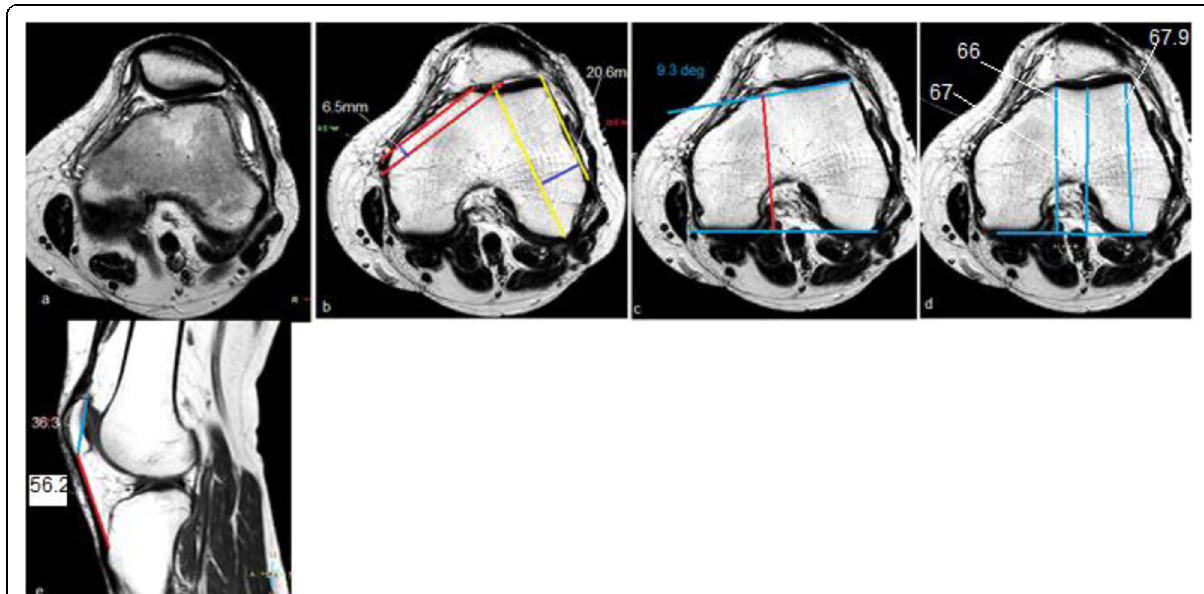
Fig. 15 a – d MRI images for lateral patellar tilt with patella alta and trochlear dysplasia type C as predisposing factors. a Axial T2-weighted image showed loss of contact between the patellofemoral joint surfaces laterally. b Axial T2-weighted image showed trochlear facet asymmetry 32% (normally not less than 40%). c Axial T2-weighted image showed lateral inclination angle 9.3° (normally not less than 11°). d Axial T2-weighted image showed a trochlear depth of 1.5 mm (normally up to 3 mm). e Sagittal PDWI showed patella alta (Insall – Salvati index about 1.5)